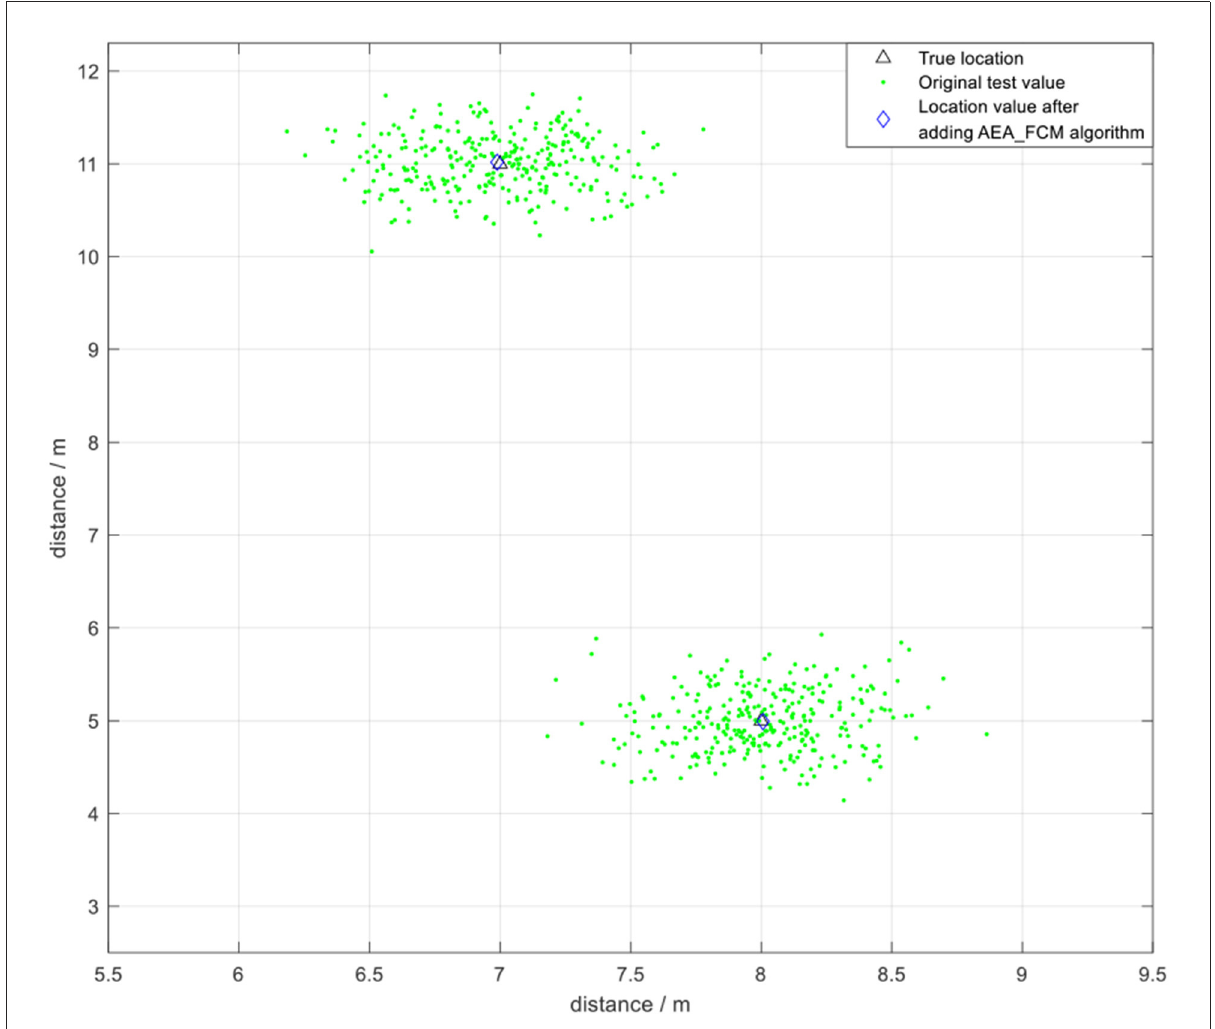
FIGURE17 The positioning effect under AEA_FCM algorithm optimization.